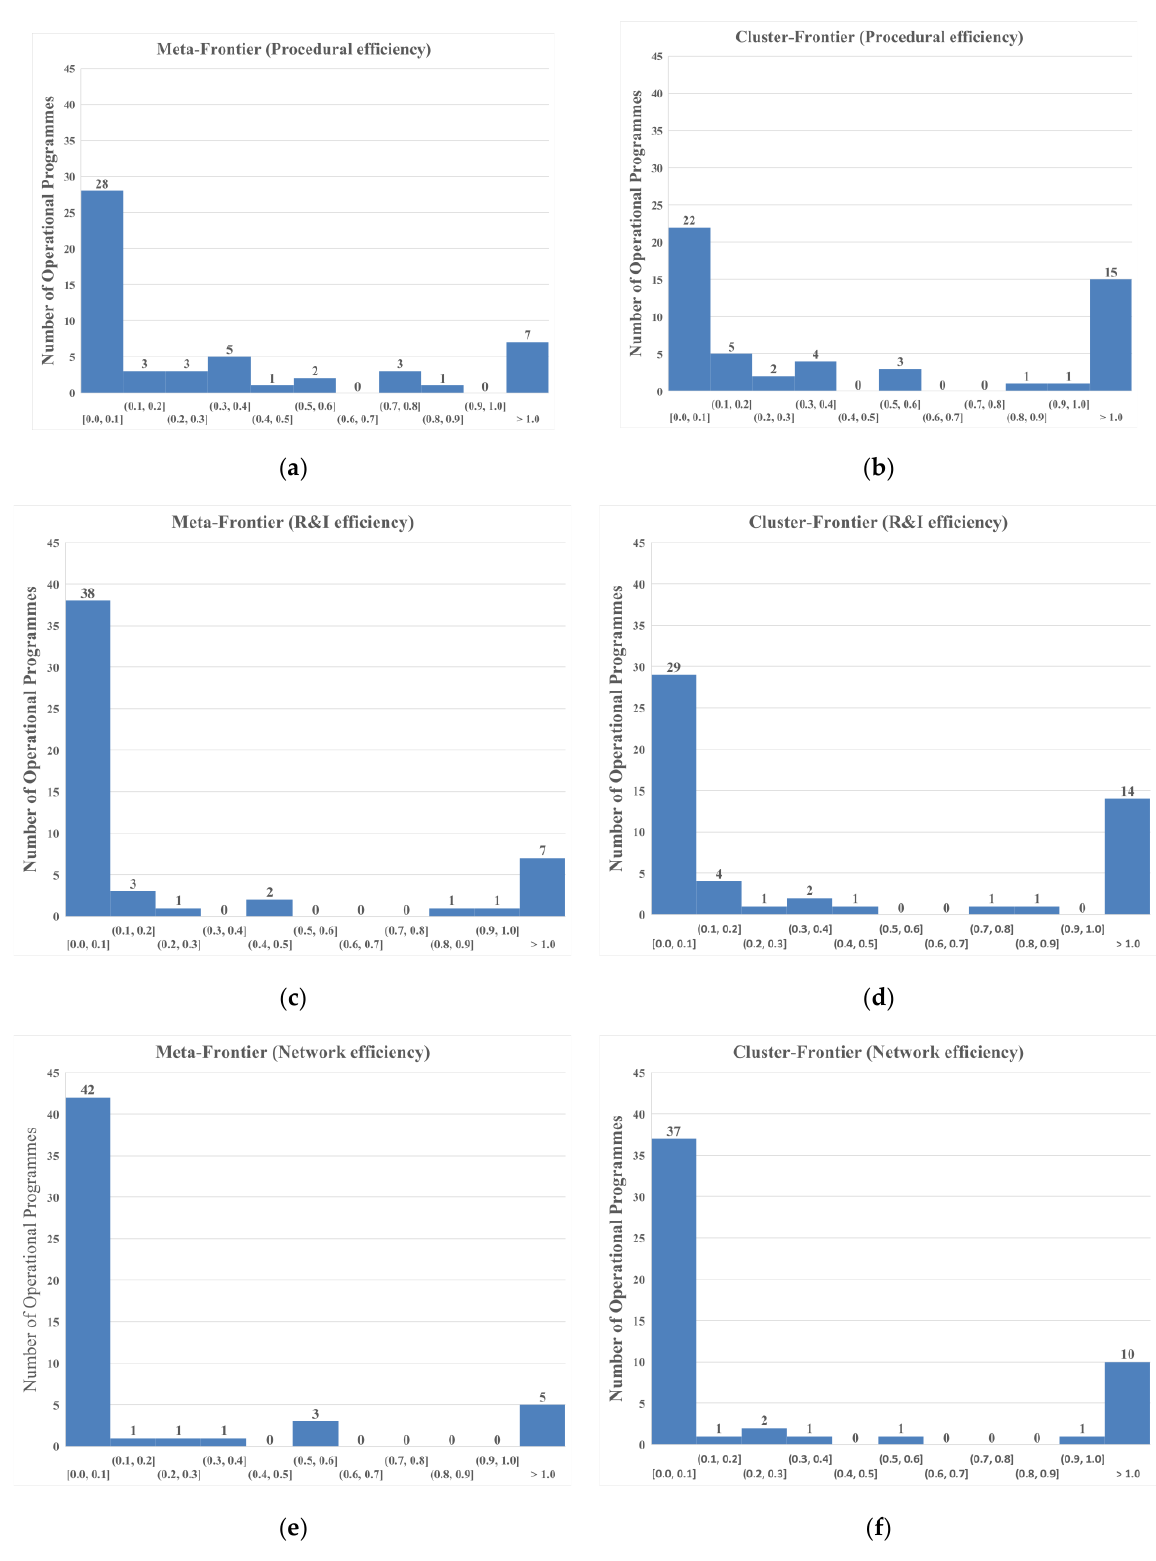
Figure 3. Number of OPs at different subintervals of efficiency scores based on cluster- and meta- frontiers, respectively, for Procedural efficiency ( a , b ), R&I efficiency ( c , d ) and overall network effi- ciency ( e , f ).